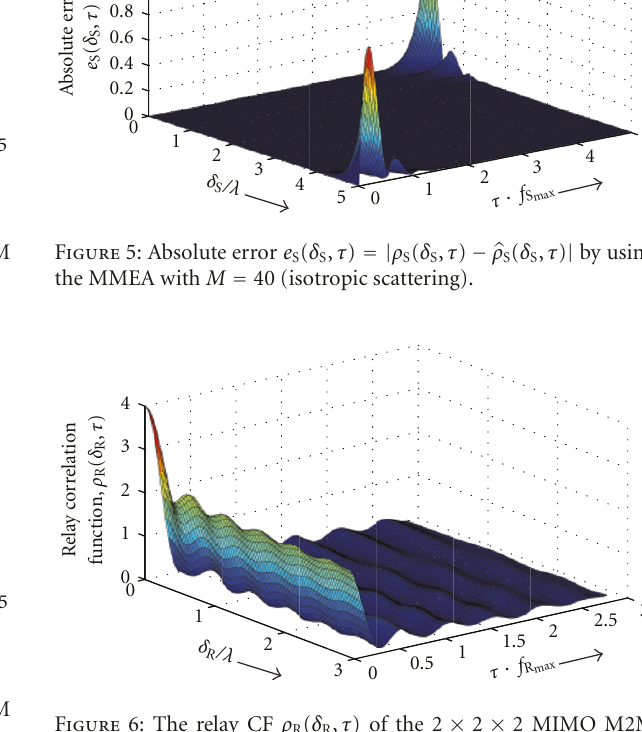
Figure 6: The relay CF ρ R ( δ R , τ ) of the 2 × 2 × 2 MIMO M2M reference channel model under isotropic scattering conditions.